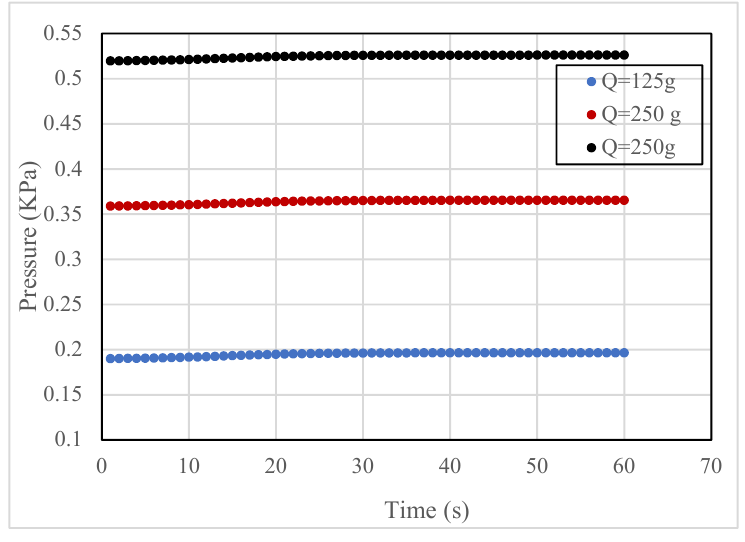
Figure 10. Variation curve of pressure with time under different grouting amount.